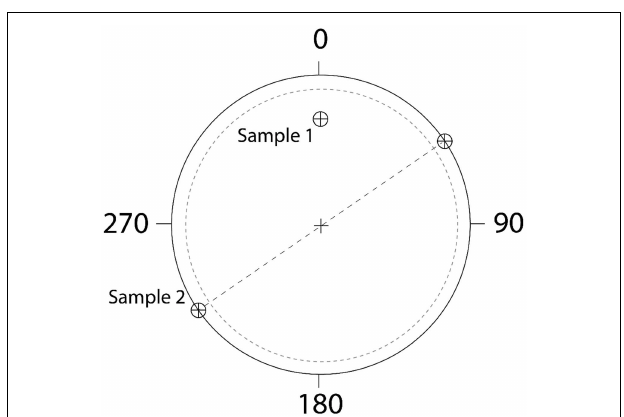
FIGURE 3 | Example of AMS data projection. The confidence zone between 0 ◦ to 5 ◦ is limited by the dashed circle.